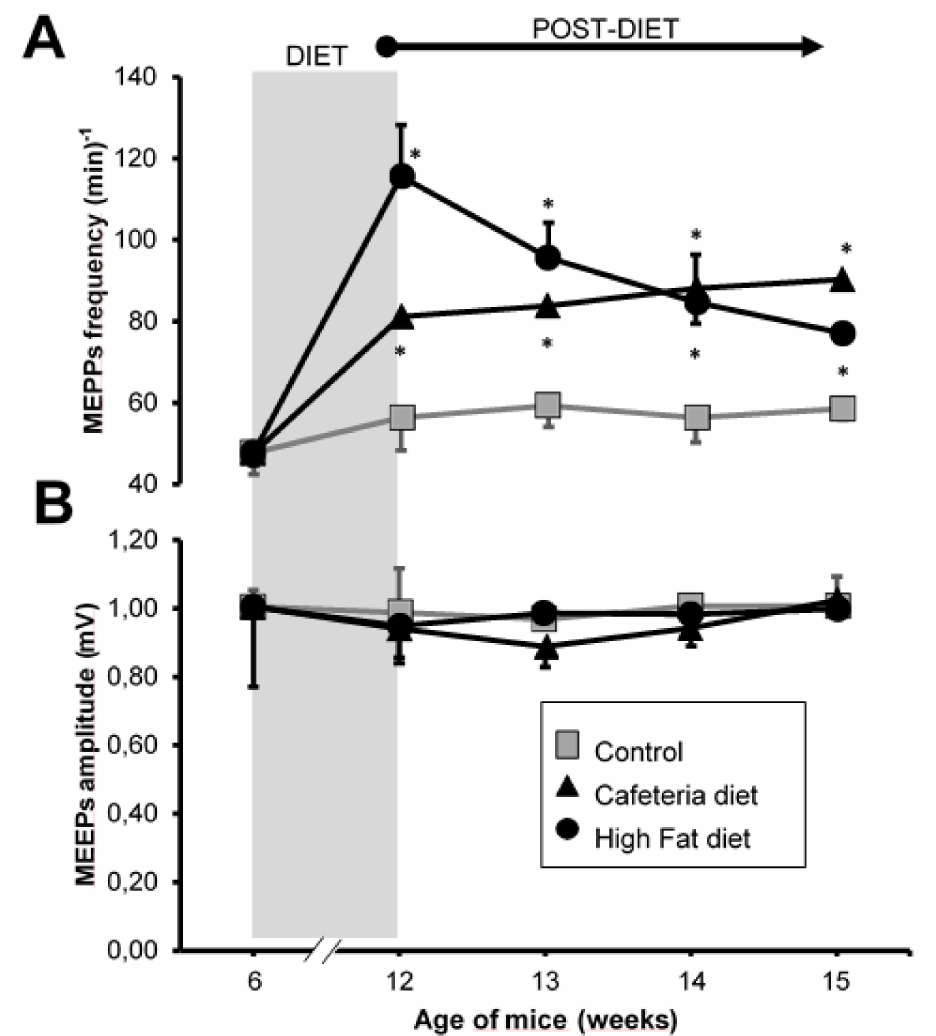
Figure 3. Intracellular recordings. ( A ) Frequency of miniature endplate potentials (MEPPs) expressed as number of events per minute. ( B ) Mean amplitude of the MEPPs expressed in mV. Grey area, period in which the animals were exposed to the CAD or HFD diets. Values are expressed as the mean ± SEM. For each experimental series, N = 4 animals. * p < 0.05 with respect to control values. Cafeteria diet group, CAD. High-fat diet group,